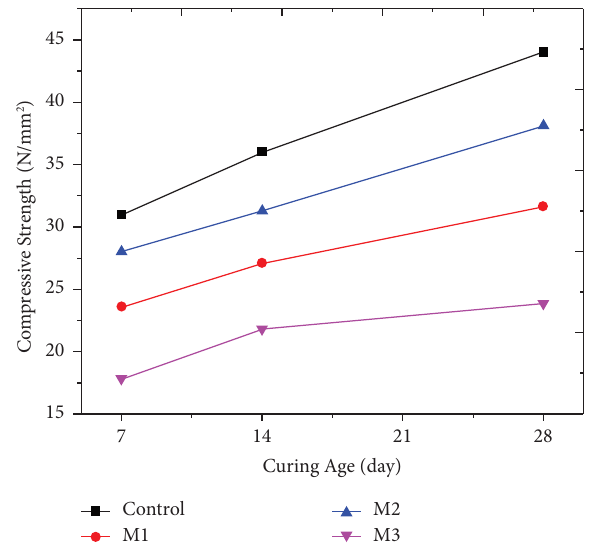
Figure 11: Compressive strength of concrete samples at diferent curing days.